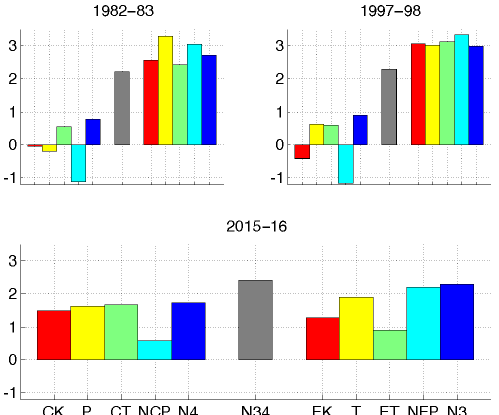
Figure 1. The December–February Niño 3.4 (N34), Niño 3 (N3), and Niño 4 (N4) indices and other various eastern and central Pa- cific projection indices for each of the three events. Eastern (central) Pacific indices are represented right (left) of the Niño 3.4 bar. EK and CK: E and C indices from Kao and Yu (2009); P and T: P and T (cid:48) indices from Chen and Wallace (2016); ET and CT: E and C in- dices from Takahashi et al. (2011); NEP and NCP: eastern Pacific and central Pacific indices as defined by Ren and Jin